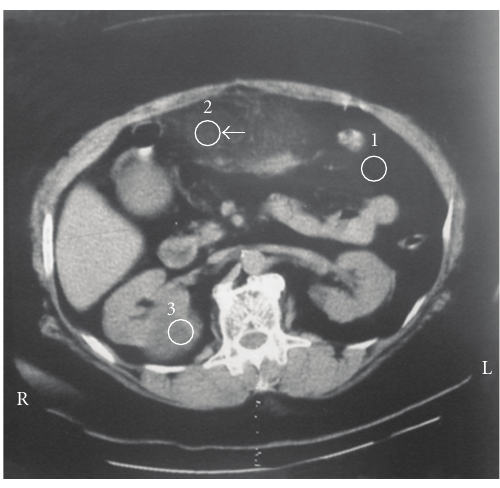
Figure 1: Axial CT view illustrating the presence of an inflamma- tory focal fatty mass just under the anterior abdominal